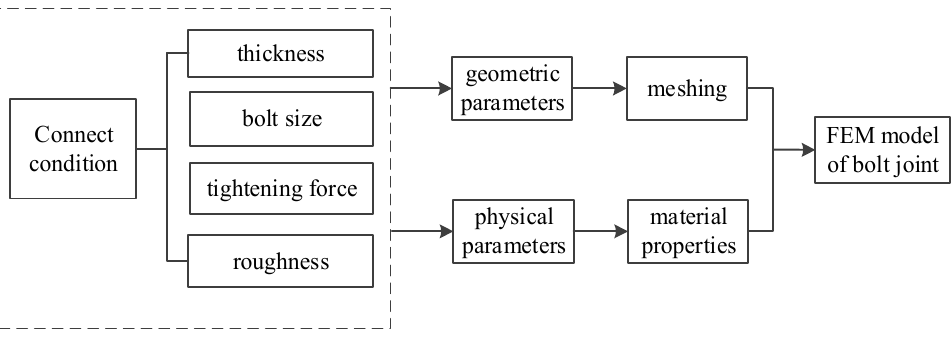
Figure 6. Application of transition interface model in finite element analysis.